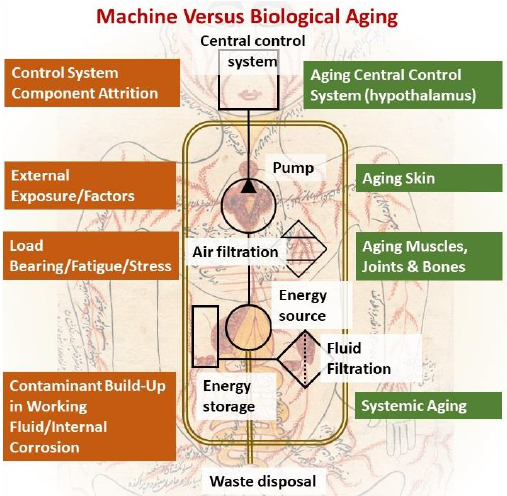
Figure 1. Causes of aging: Juxtaposition between mechanical fluidic and biological systems.